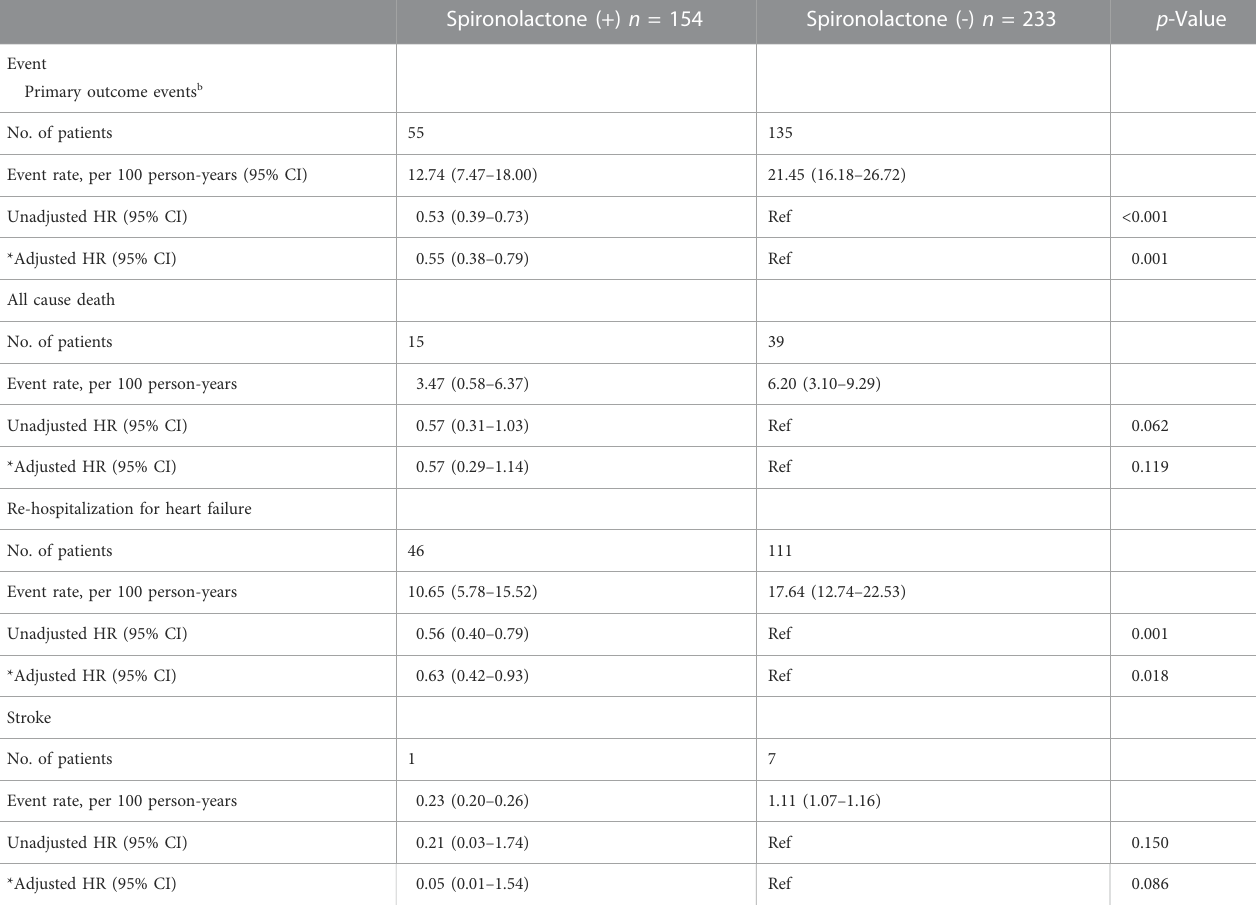
TABLE 3 Primary outcomes events in patients with chronic kidney disease taking and not taking spironolactone a . Spironolactone (+) n =